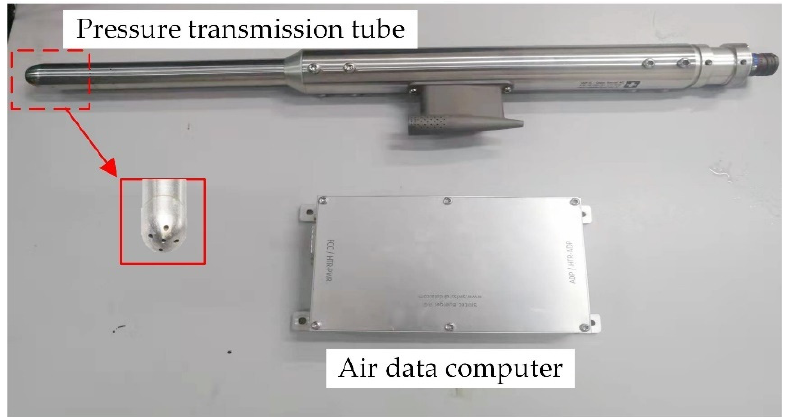
Figure 13. Five-hole probe.